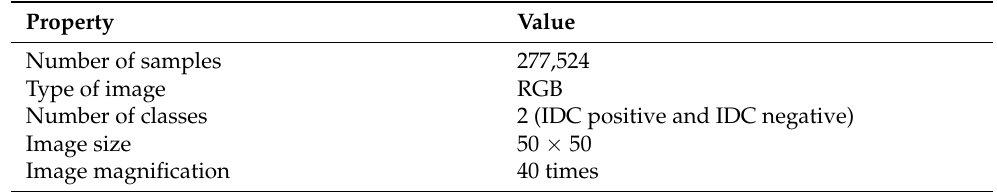
Figure 7. Dataset description. Table 1. Dataset specification used for the proposed